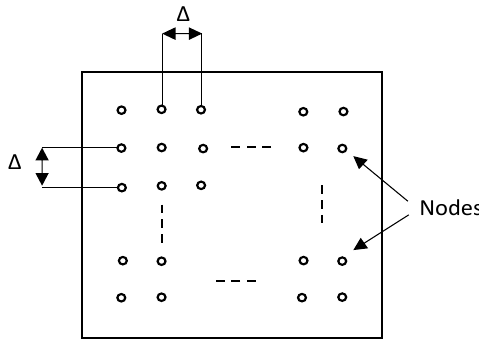
Figure 7. The structure of the network topology used in